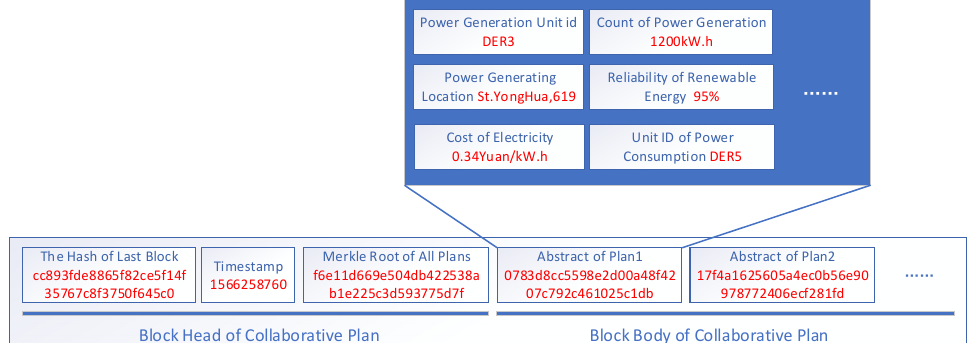
Figure 4. Structure of collaborative plan block in VPPBN.